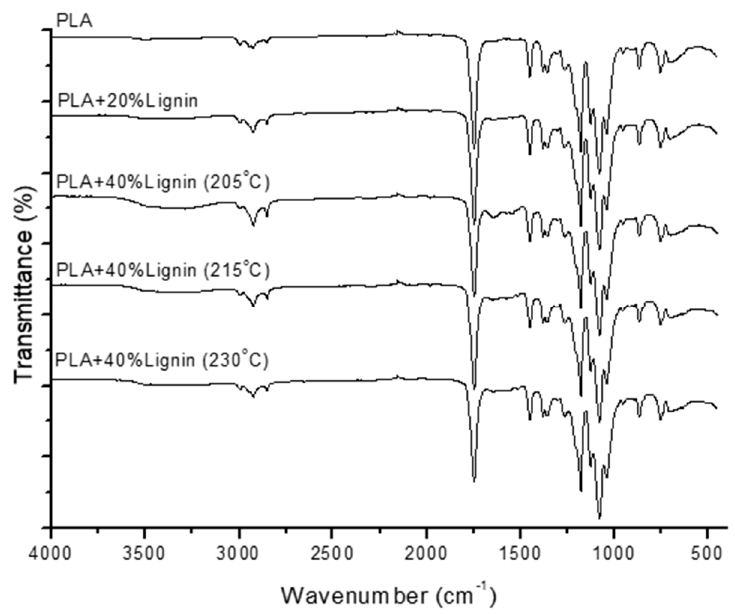
Figure 6. FT-IR spectra of PLA and PLA / lignin biocomposites.